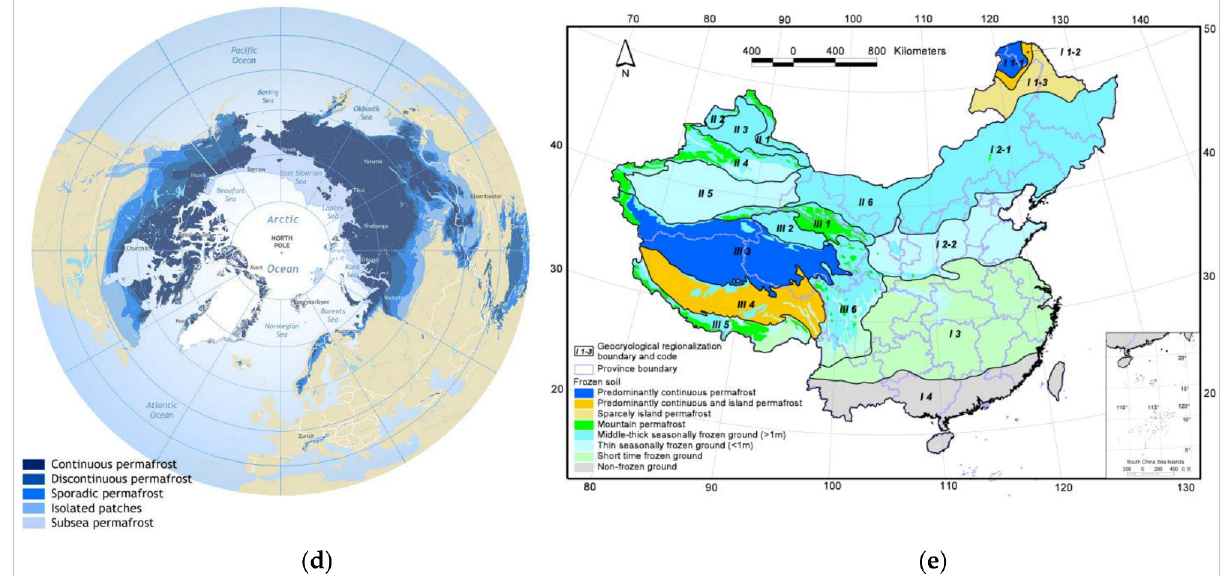
Figure 2. ( a ) Sketch of permafrost variation [37]. ( b ) Annual Amplitude of Soil Temperature [38]. ( c ) Soil layer of constant temperature. ( d ) Northern Hemisphere Permafrost Distribution [39]. ( e ) Distribution of permafrost types in China